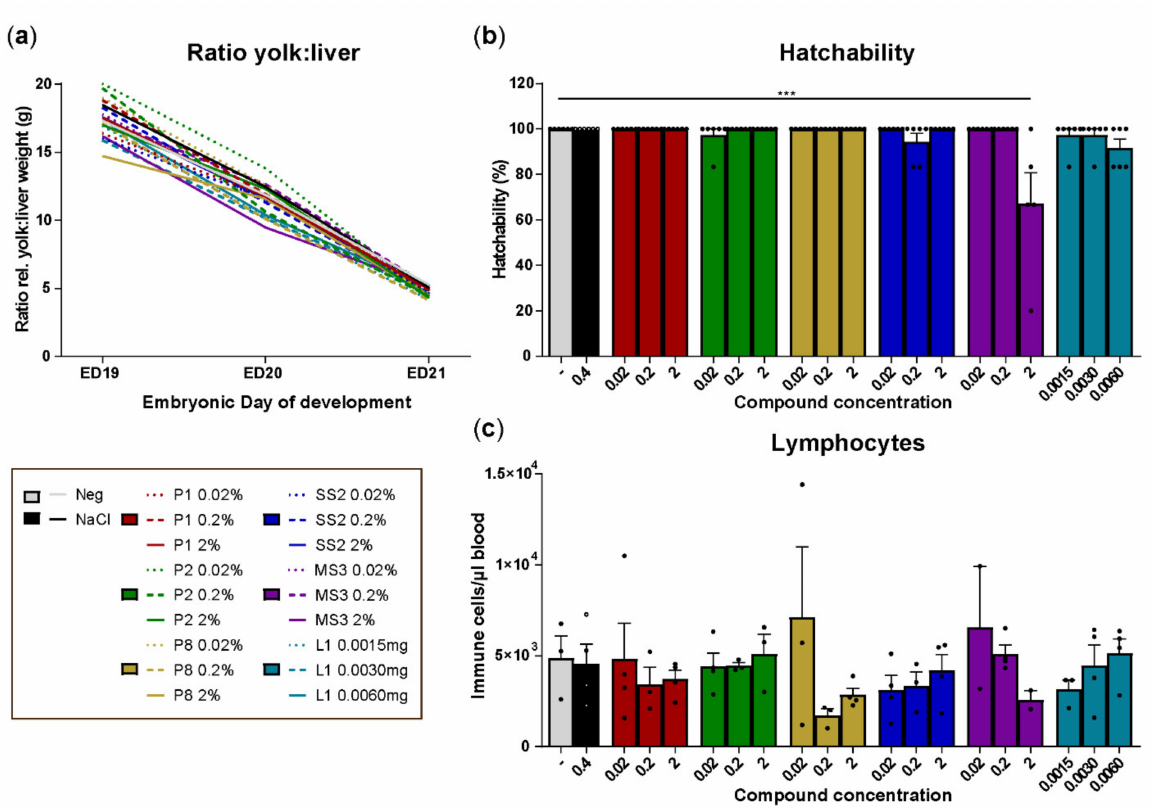
Figure 2. In ovo screening of feed compounds for their effect on embryonic growth, hatching, and peripheral lymphocyte numbers. ( a ) Effect of compound injections in embryos on the ratio of relative yolk and liver weight during late embryonic development, n = 6 per group per ED. ( b ) Effect of compound injections on hatchability (%) at ED21, n = 6 per group. ( c ) Effect of compound injections on the numbers of lymphocytes in whole blood in chicks immediately post-hatch. Non- injected eggs were included as the negative control and 0.4% saline solution as the solvent control, n = 4 per group. Mean + SEM is shown of compounds of polysaccharides (P1, P2, P8), simple sugars (SS2), modified sugars (MS3), and lipids (L1) in different concentrations (0.02, 0.2, 2%, or 0.0015, 0.0030, 0.0060 mg) and statistical significance is indicated as *** p <